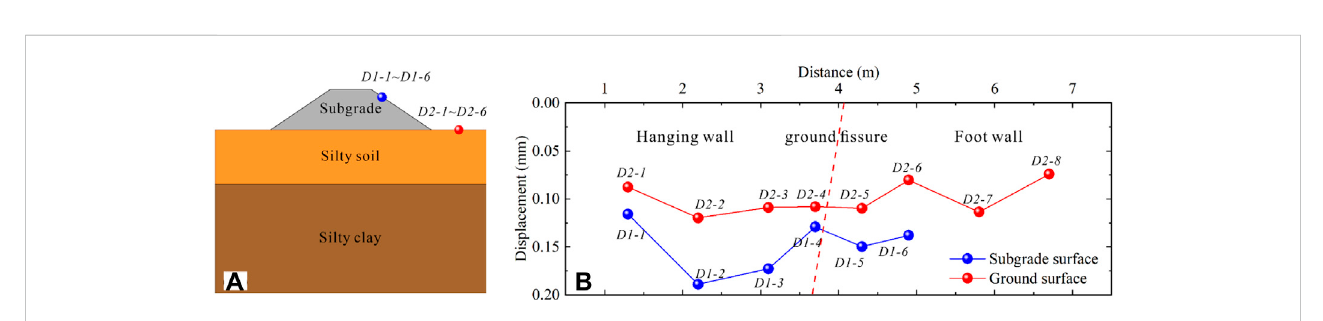
FIGURE 12 (A) Displacement measuring points of the model; (B) Peak of displacement along the